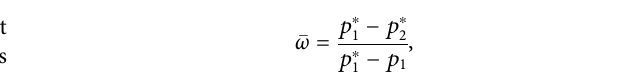
Frontiers in Energy Research |